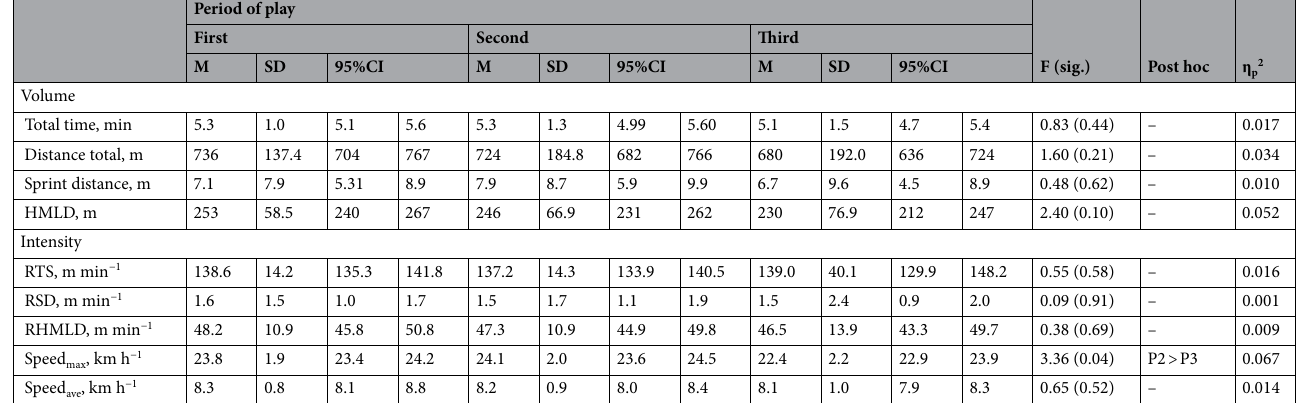
Table 4. Means (M), standard deviations (SD) and 95% confidence intervals (95% CI) for indicators of volume and intensity (per unit playing time) of effort by period of play during U16 Hockey5s matches, and results of the linear mixed model analysis, post-hoc comparisons and estimated effect sizes (η p 2 ). HMLD, high metabolic load distance; RTD, relative total distance; RSD, relative sprint distance; RHMLD, high relative metabolic load distance.